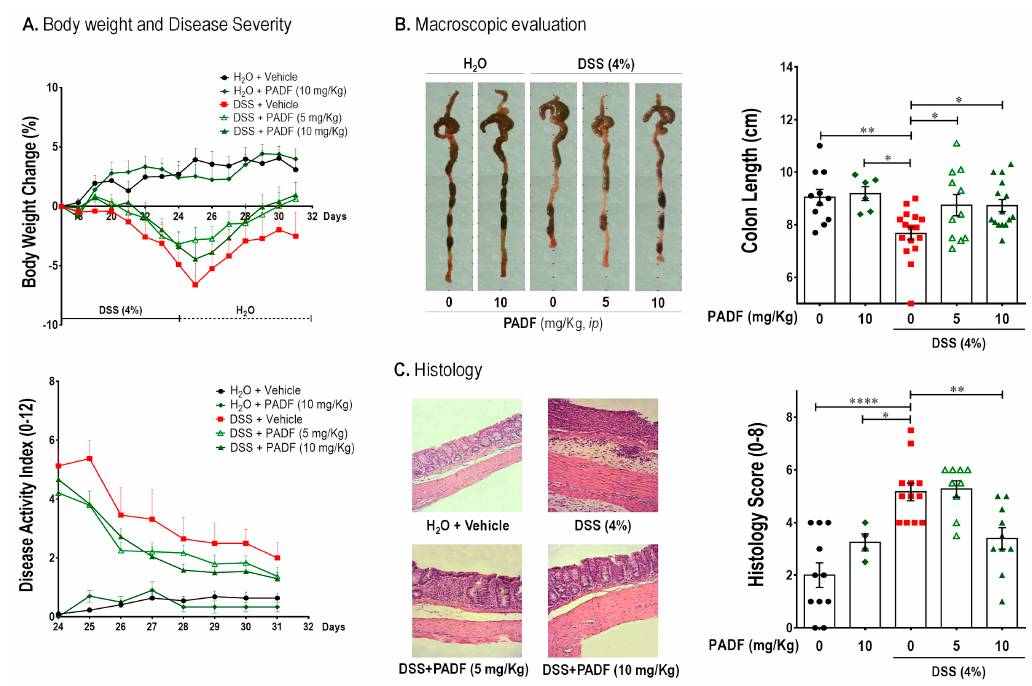
Figure 2. Chronic dextran sulfate sodium (DSS)-induced colitis is effectively treated by P. angulata fraction (PADF). Chronic colitis was established with two cycles of DSS (4%) interrupted by normal drinking water. Affected mice ( n = 11–16 per group) were treated with PADF (5 and 10 mg/Kg/day, ip ) or vehicle (saline) for 7 days. PADF alleviated colitis promoting a trend of increased body weight and reduced disease activity index (DAI) by the end of the experiment ( A ). Moreover, PADF-treated mice showed significantly longer colons ( B ) and lower histological scores with marked reduction of epithelial damage and cell infiltration ( C ). Pictures from representative animals are shown. Results represent the mean ± SEM ( n = 6–18) of three independent experiments. * p < 0.05, ** p < 0.01, **** p < 0.0001 significantly di ff erent from DSS-colitis control, as calculated by ANOVA (Dunnett’s multiple comparisons